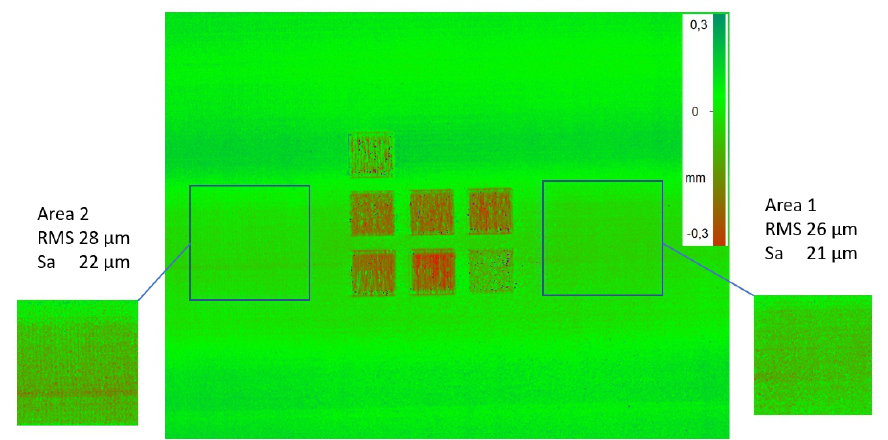
Figure 16. Presentation of the height distribution of layer 10 before powder recoating takes place from right to left. The measured sample has a size of about 150 × 150 mm (x, y). Two fields of the powder bed are chosen for investigation. For area 1 ( right ): Sa = 21 µ m, RMS = 26 µ m, powder appears rather smooth. For area 2 ( left ) : Sa = 22 µ m, RMS = 28 µ m, suggests slight ripples in the gray values. For each area, approximately 90,000 height values are obtained, and the lateral dimension is approximately 25 × 25